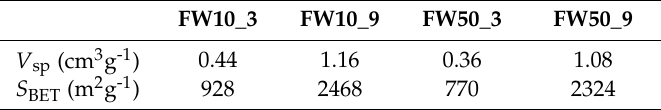
Table 4. Textural data of samples shown in Figure 6.